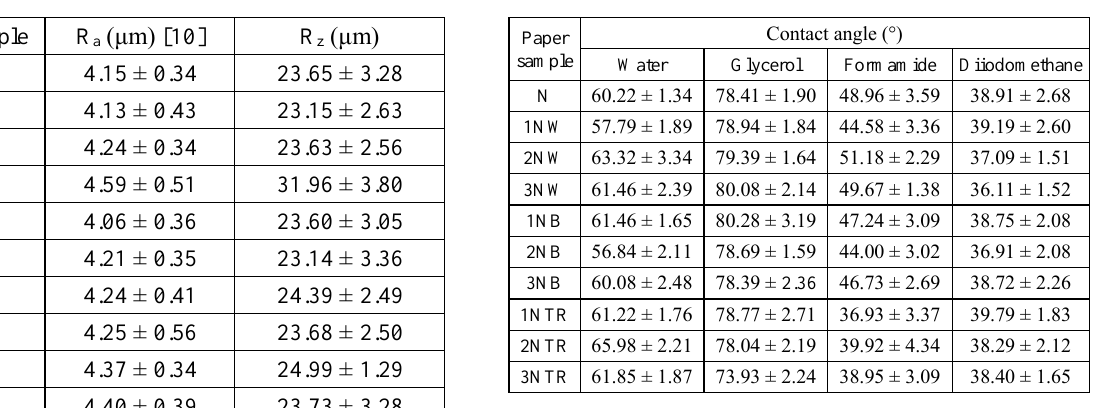
Table 5. Contact angles measurements on laboratory-made papers